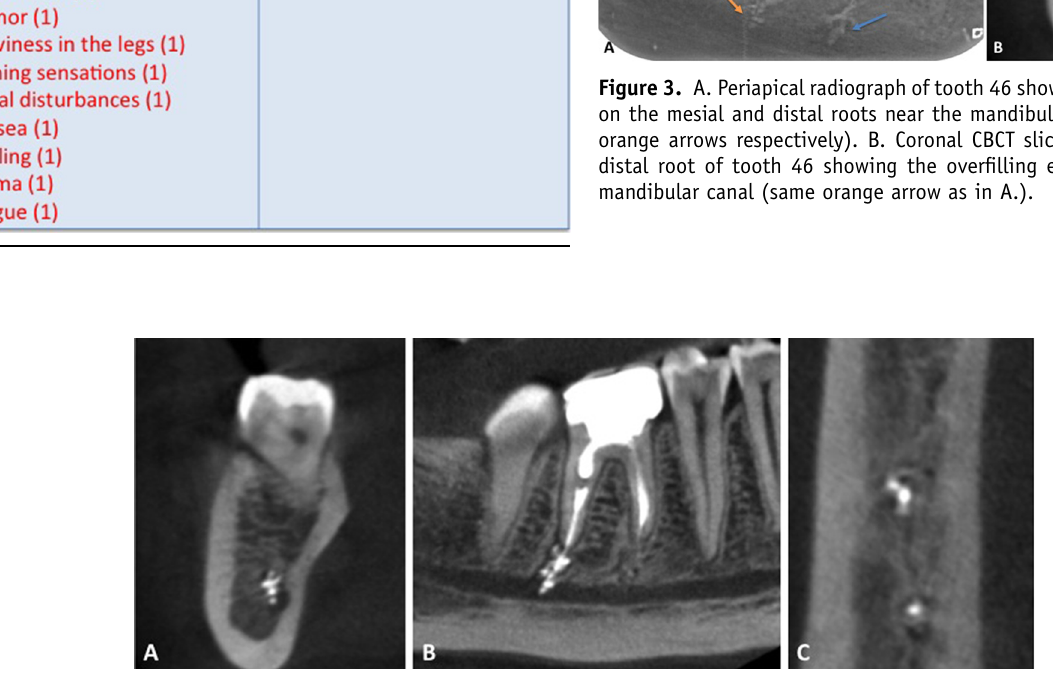
Figure 4. CBCT images at 1-year follow-up. Bone sclerosis can be observed on coronal (A), sagittal (B) and axial (C)